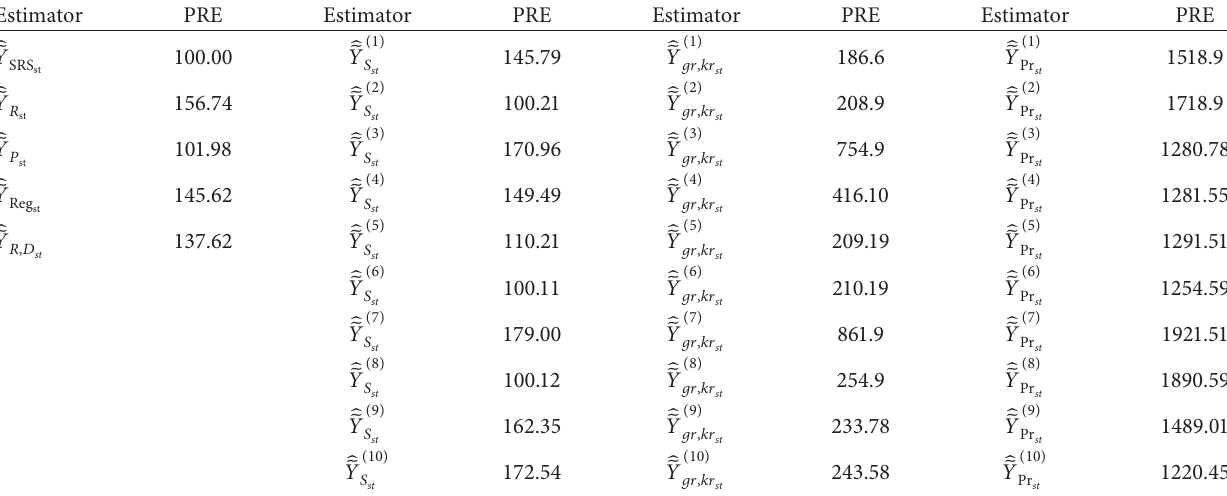
Table 10: Simulation result for the percent relative efficiencies of the suggested family of exponential cum ratio type estimators w.r.t. existing estimators for different stratum.